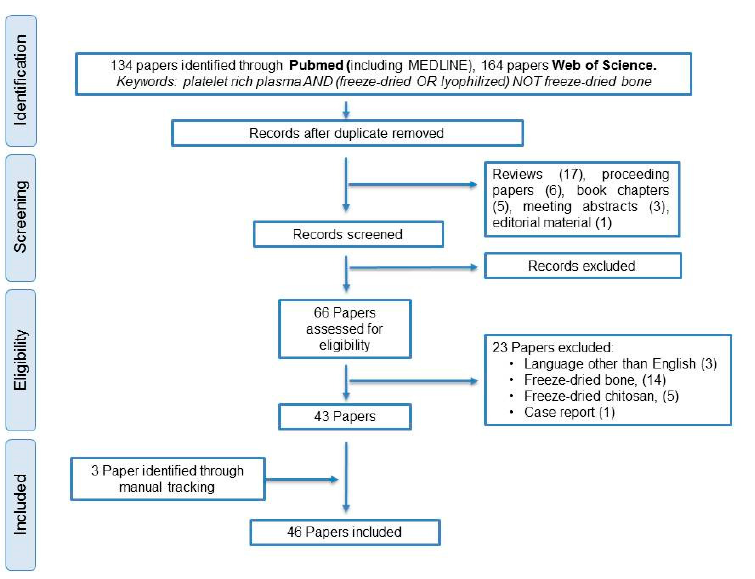
Figure 1. PRISMA (Preferred Reported Items for Systematic Reviews and Meta-Analyses) workflow.